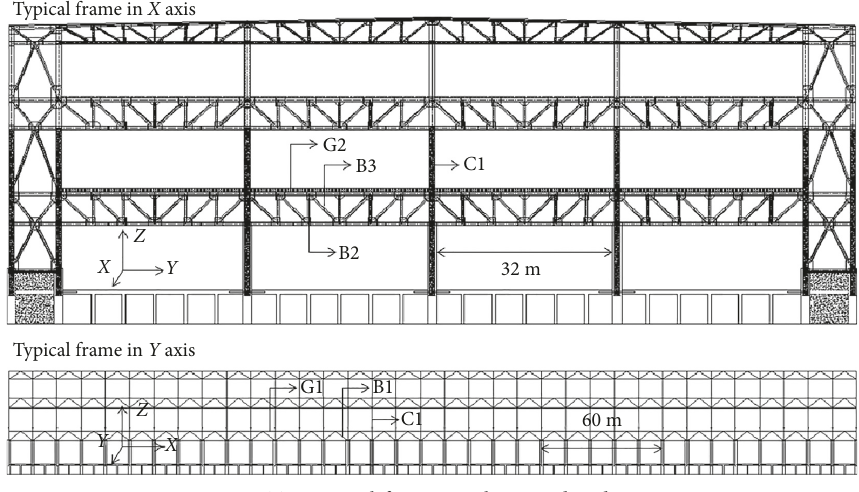
Figure 5: Two typical frames in the X and Y directions. Table 1: The steel sections of the 2nd story of the analyzed high-tech factory.